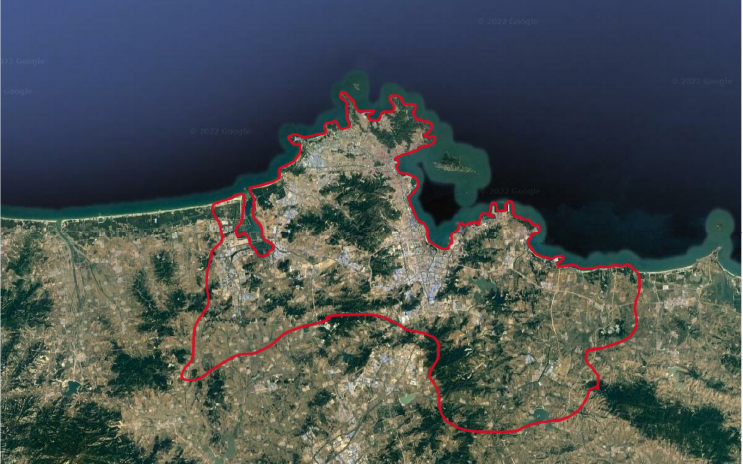
Figure 1. Huancui District, Weihai City.